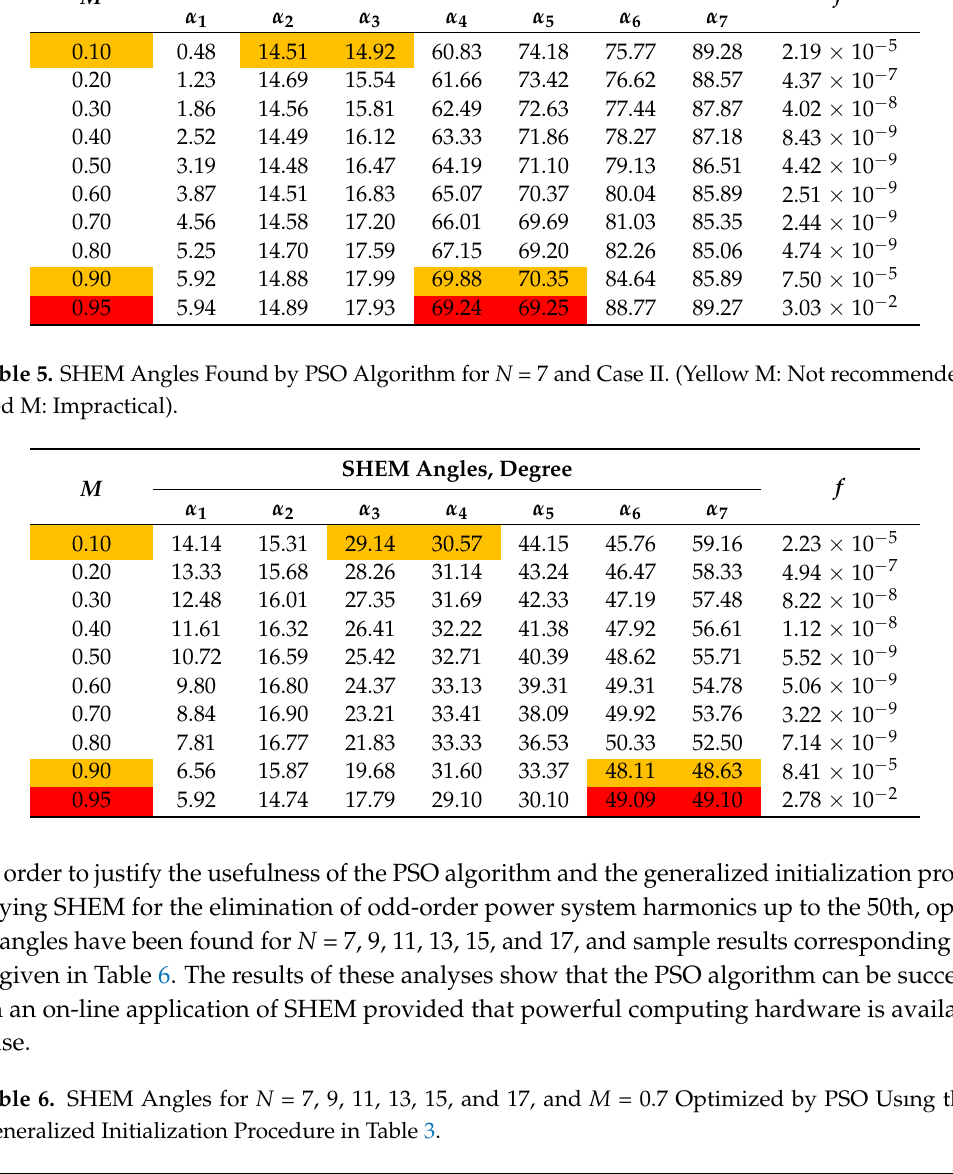
Table 4. SHEM Angles Found by the PSO Algorithm for N = 7 and Case I. (Yellow M: Not recommended, Red M: Impractical). SHEM Angles, Degree M